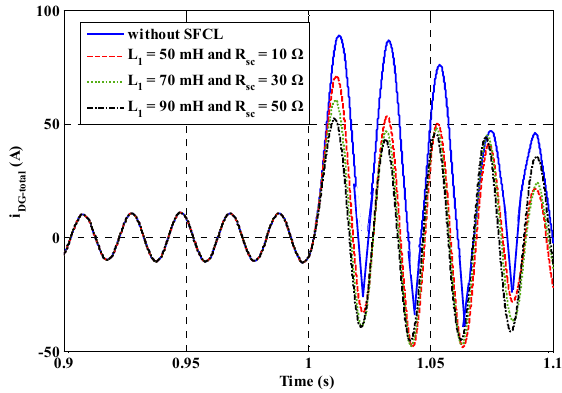
Figure 14. Fault current contributed by the DG units under the internal fault (A ‐ phase).